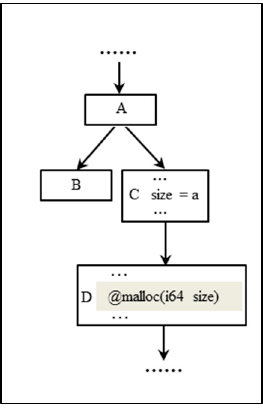
Figure 6. An example of basic block transition.